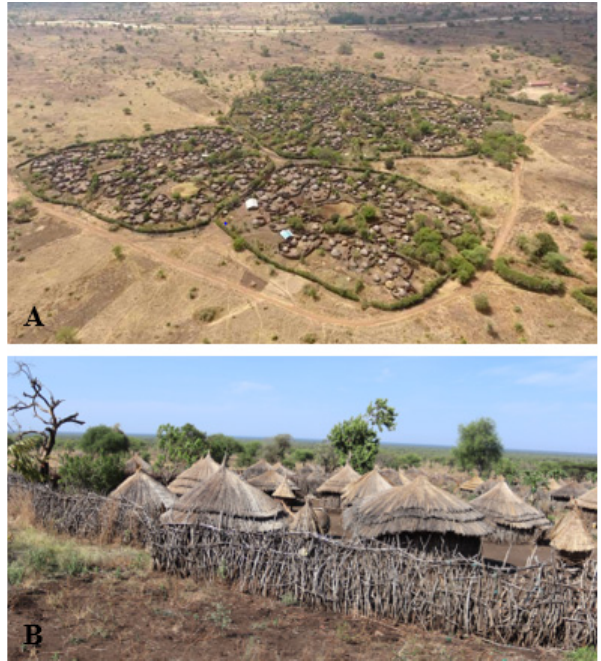
Figure 2. Aerial view of manyatas in the Nagule Angolol parish ( A ). Each of the manyatas has a perimeter hedge and internal partitions made of stick aggregates, which delineate homesteads. ( B ): A ground view of the organisation of a typical manyata in the study area. Boundaries of homesteads and households are demarcated by fences made of sticks.